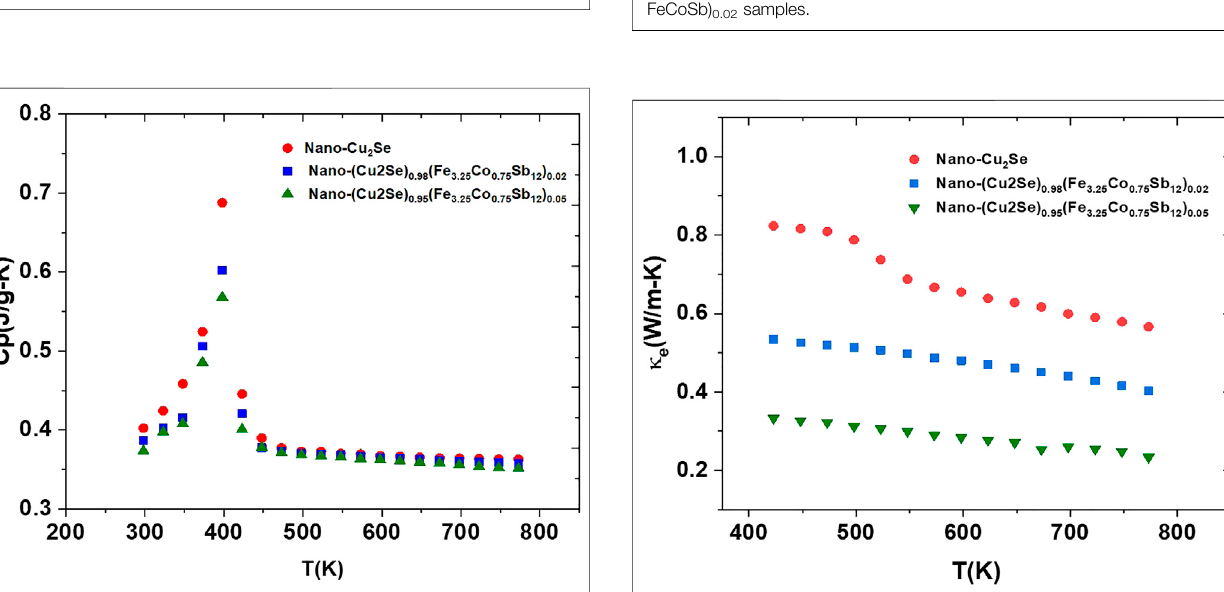
FIGURE 9 | The total thermal conductivity vs. temperature for nano- Cu